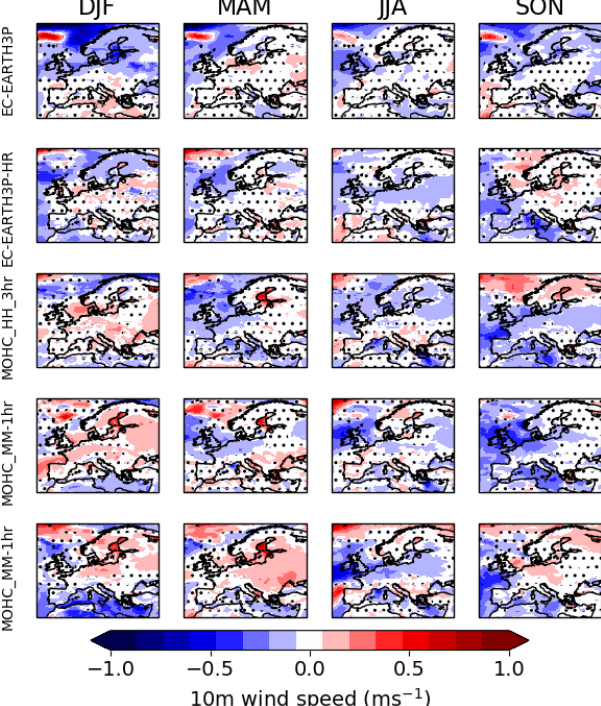
Figure A1. Seasonal-mean difference in 2m temperature between 1980–2010 and 2020–2050 for the five different climate model sim- ulations used in this study (see Table 1 for further details of the models). Stippling shows grid points where no statistically signif- icant climate change signal was found when using a two-sample t test (Wilks, 2011).